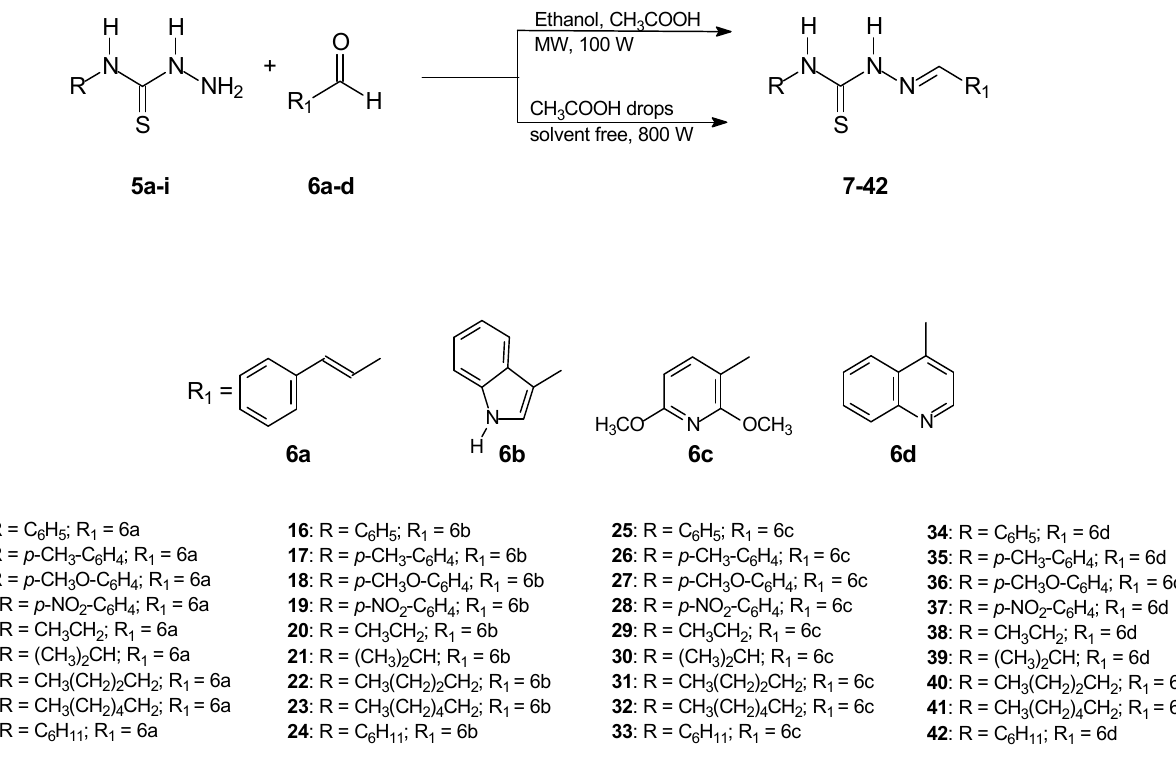
Scheme 1. Synthesis of thiosemicarbazones by microwave irradiation.